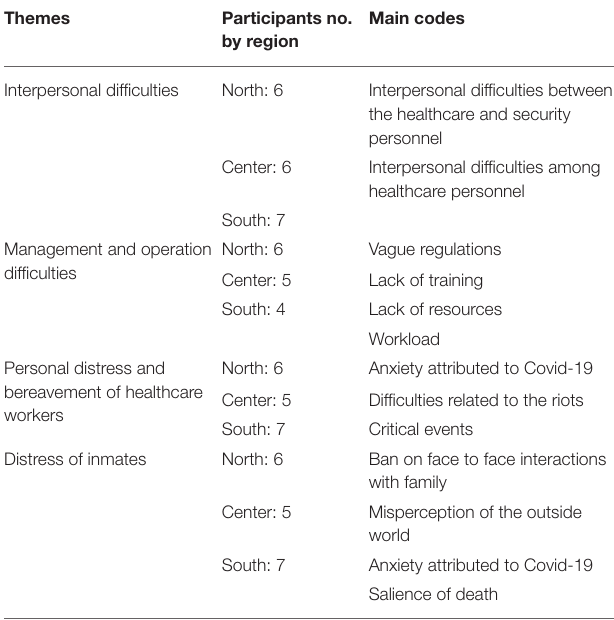
TABLE 2 | Themes and main codes.